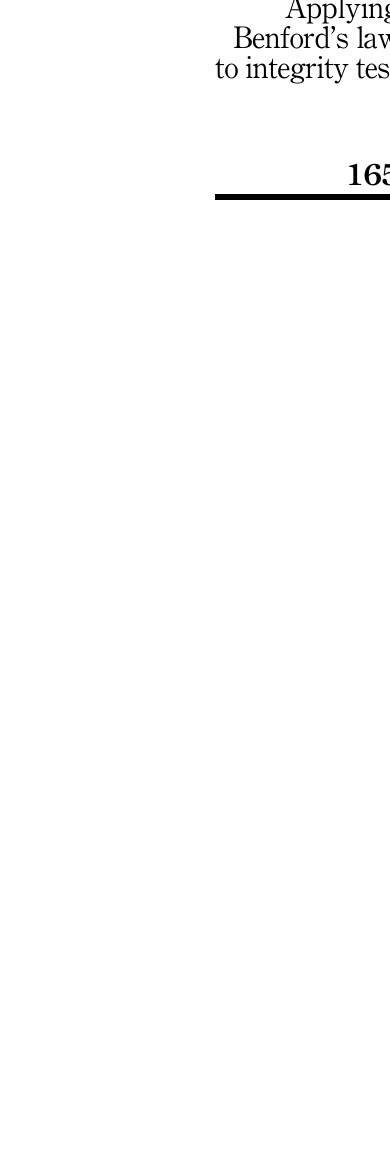
Table 4. Percentage of each first digit in each ERP module ’ s